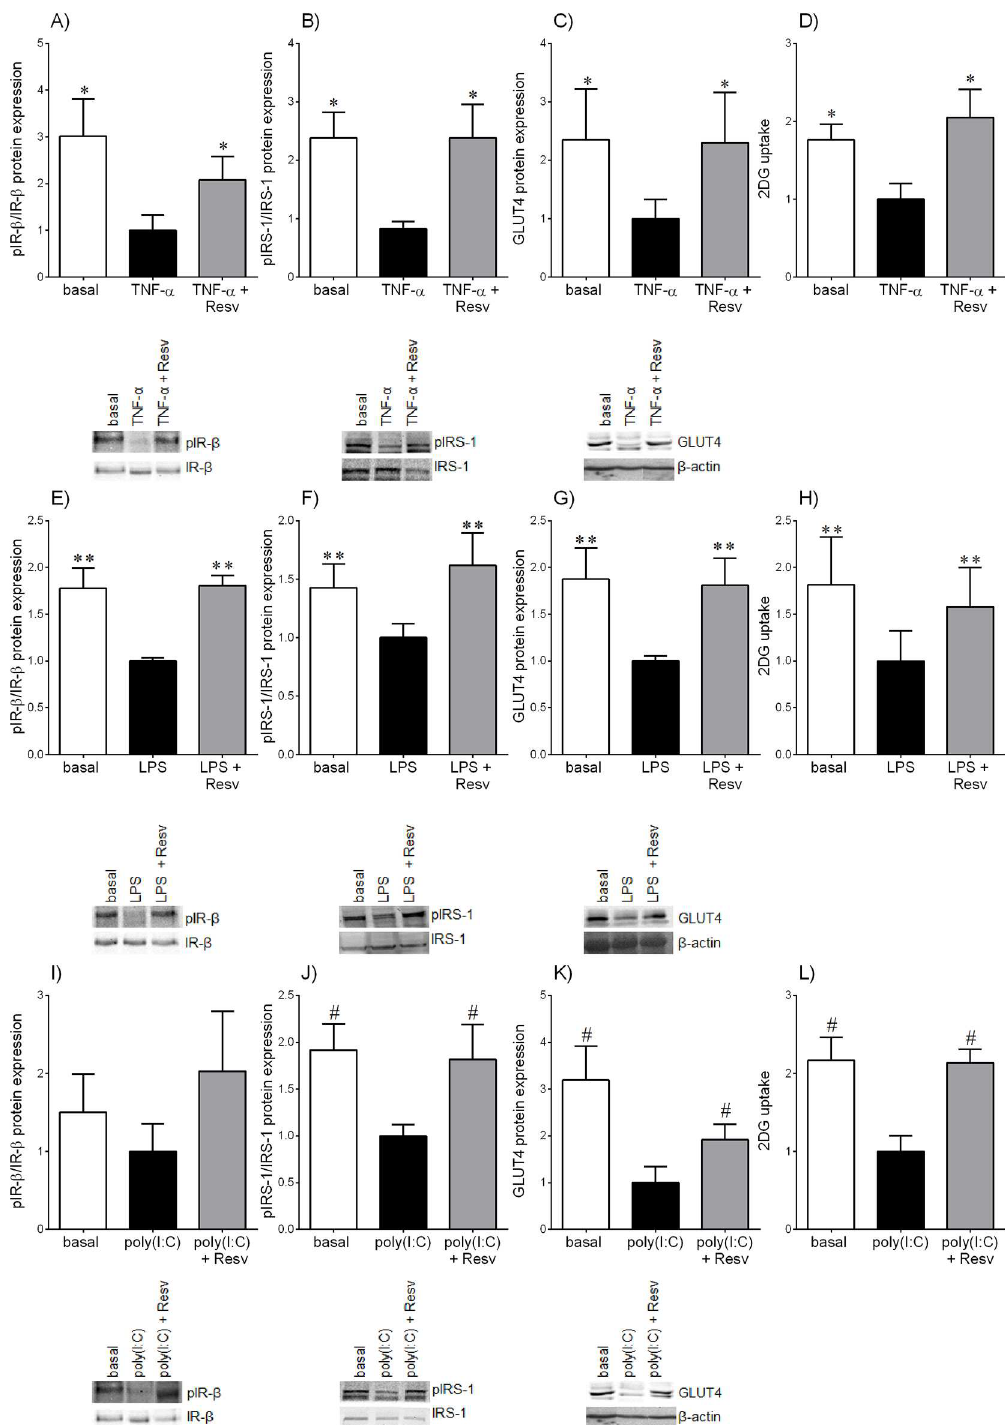
Fig 7. Effect of resveratrol on the insulin signalling pathway. Human skeletal muscle tissue was incubatedwith (A-D) 10 ng/ml TNF- α , (E-H) 10 μ g/ml LPS or (I-L) 50 μ g/ml poly(I:C) for 20 h with or without 200 μ M resveratrol (resv), followedby a 30 min incubationwith 0.1 μ M insulin(n = 6 patients). (A,E,I) Phosphorylated IR- β (pIR- β ) protein expressionwas normalised to total IR- β protein expression. A representative Western blot from 1 patient is also shown. (B,F,J) Tyrosine phosphorylated IRS-1 (pIRS-1) protein expressionwas normalisedto total IRS-1 protein expression. A representative Western blot from 1 patient is also shown. (C,G,K) GLUT4 protein expression